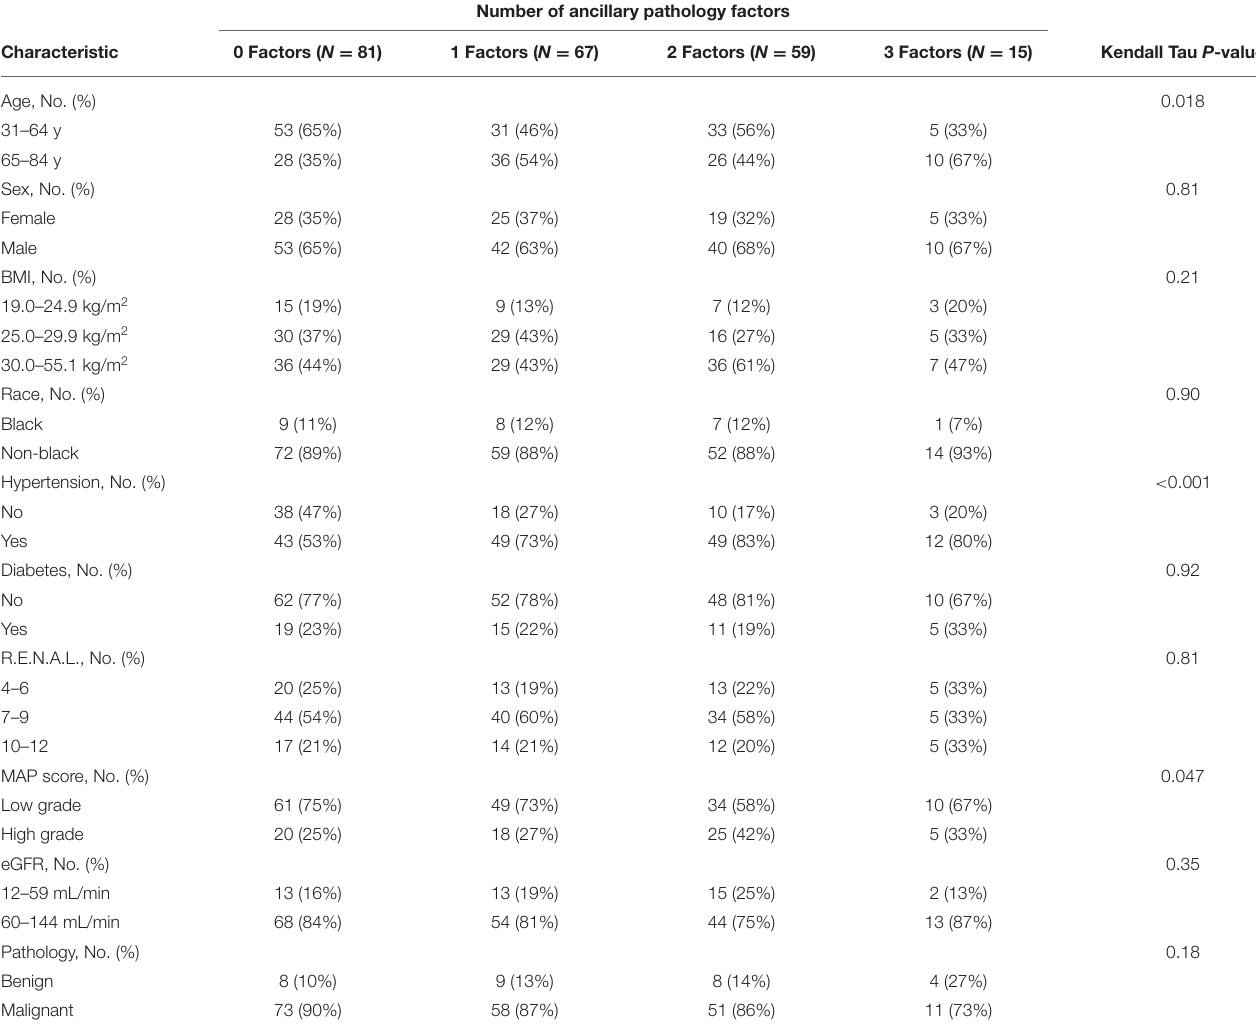
TABLE 2 | Associations of patient characteristics with the number of ancillary pathology